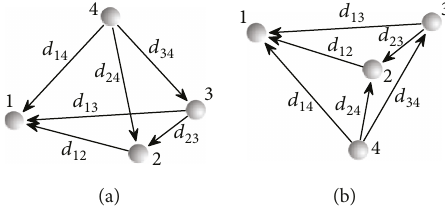
Figure 2: Two di ff erent formations for the ordinary follower that satisfy the same distance requirements: (a) orientation 1; (b) orientation